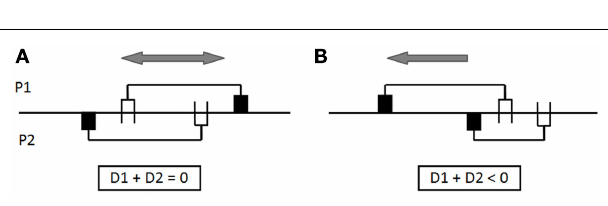
FIGURE 7 | Drift in perceptual crossing – experiment 3. In situation (A) , the perceptual crossing is balanced: ( D 1 + D 2) = 0.The receptor field of participant P1 can cover the body-object of participant P2, at the same time as the receptor field of P2 covers the body-object of P1. On the other hand, in situation (B) , the perceptual crossing is subjected to a drift toward the left: if the receptor field of P1 covers the body-object of P2, P2 will have to move to the left to find the body-object of P1; but then P1 will have to move to the left to recover the body-object of P2; and so on, resulting in a systematic collective drift of both subjects to the